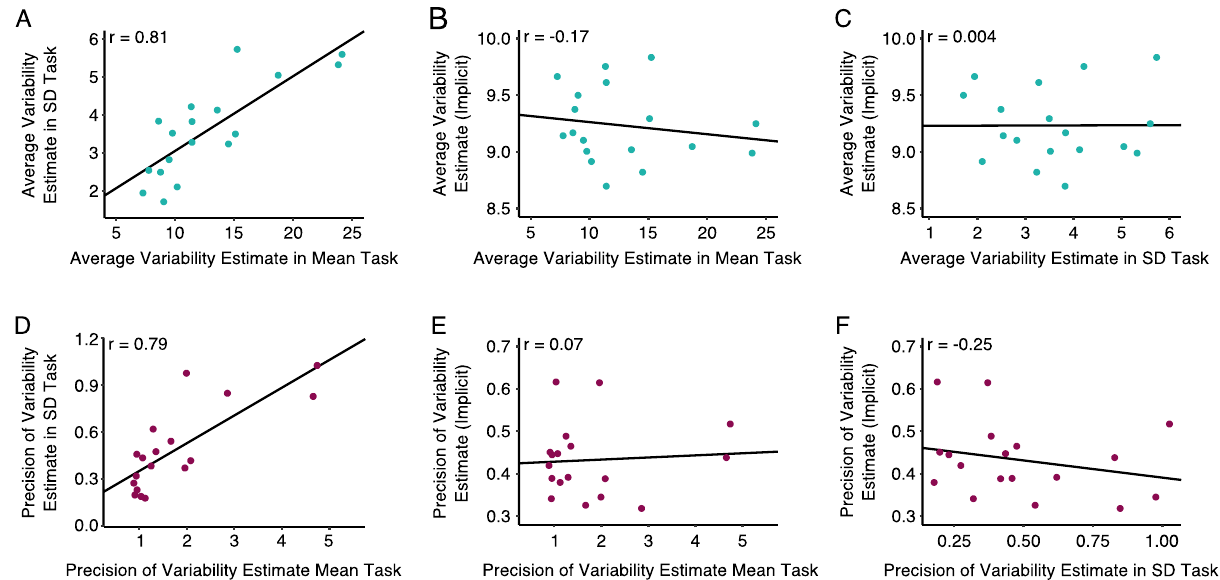
Figure 6. Estimates of uncertainty and precision of uncertainty obtained in the implicit and explicit conditions and their intercorrelations. Correlation between the ( A ) uncertainty estimates from the mean and SD task. ( B ) Correlation between the uncertainty estimates from the implicit and explicit mean tasks. ( C ) Correlation between the uncertainty estimates from the implicit and explicit SD tasks. ( D ) Plots the correlation between the precision of the uncertainty estimates from the mean and SD tasks. ( E ) Plots the correlation between the precision of the uncertainty estimates from the implicit task and the explicit mean task and ( F ) Plots the correlation between the precision of the uncertainty estimates from the implicit task and the explicit SD task. Each data point corresponds to one observer, obtained by averaging the results from the 1000 bootstrapped data